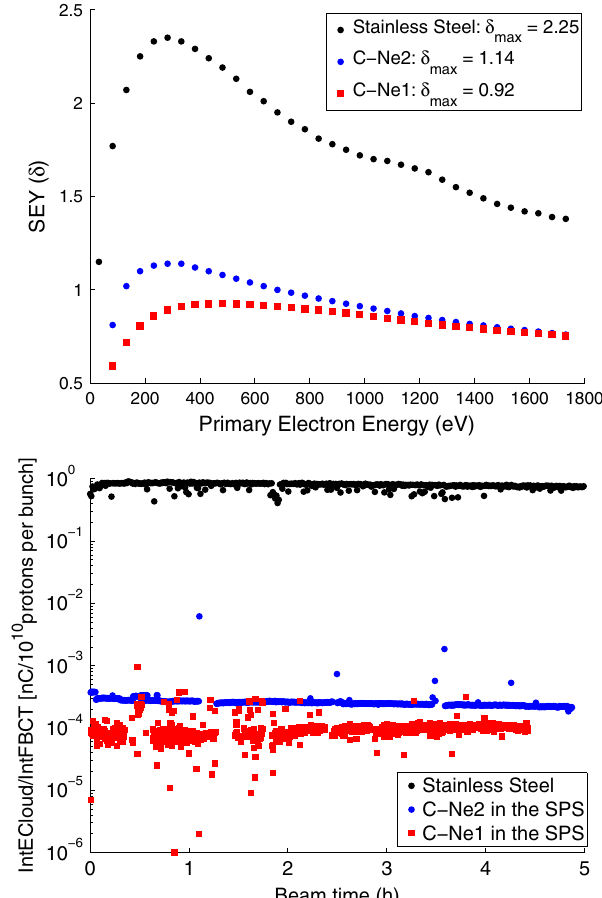
FIG. 6. Top: Comparison of the SEY of StSt and a-C coatings measured in the lab. Bottom: ECM signals from StSt and a-C coatings in the base-10 logarithm of integrated electron current signal for each supercycle divided by integrated FBCT for each supercycle [ nC = 10 10 protons per bunch] as a function of super- cycle